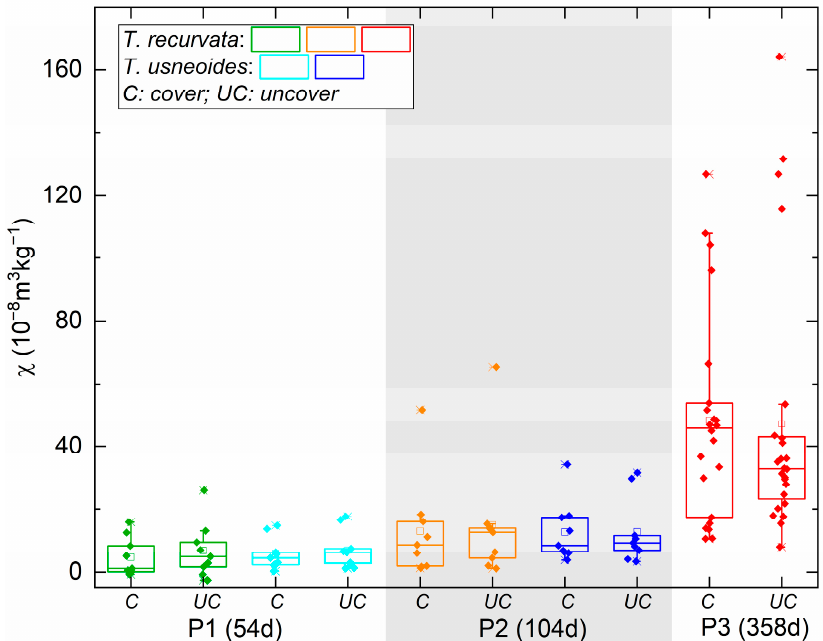
Figure 4. Mass-specific magnetic susceptibility for transplants of T. recurvata and T. usneoides .